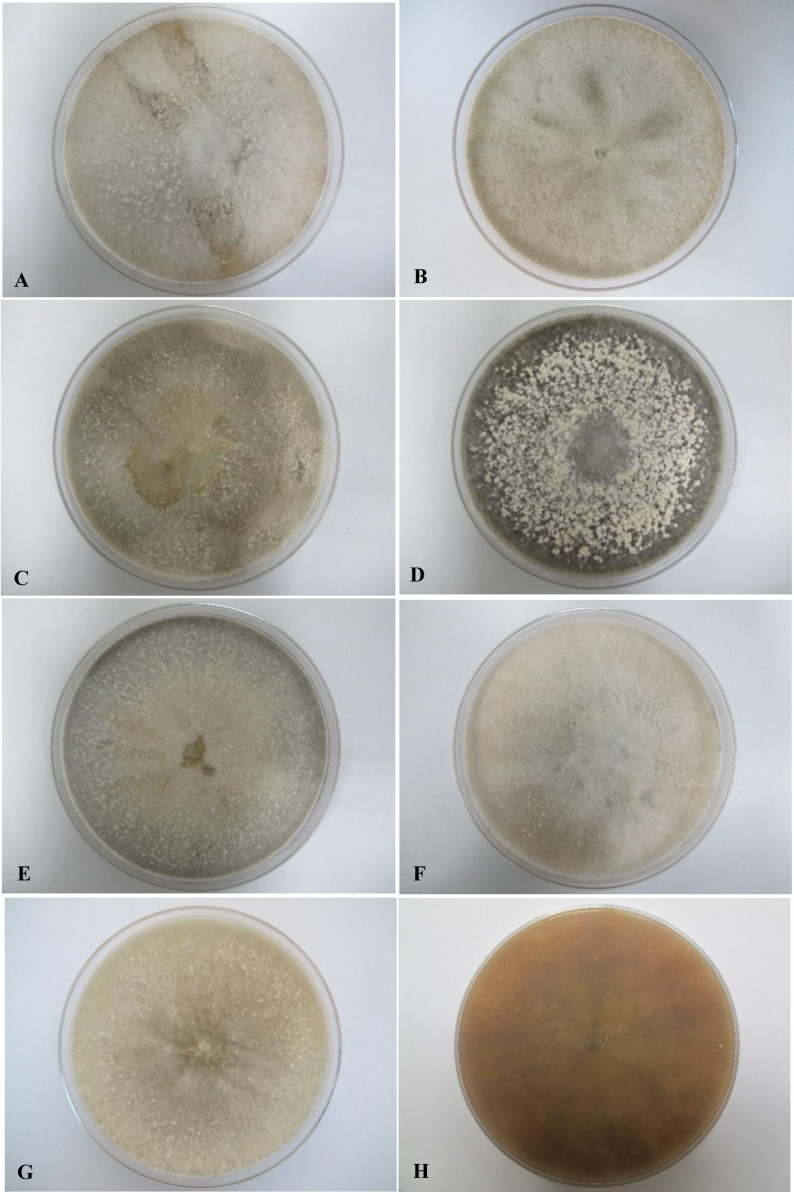
Colonial morphology of D. eschscholtzii isolates on V8 agar.(A) UM 1400, (B) UM 1094, (C) UM 1104, (D) UM 1134, (E) UM 1216, (F) UM 1217, and (G) UM 1218 were incubated at 30 °C for 5 days. (H) Uncolored with slight blackish on the reverse.